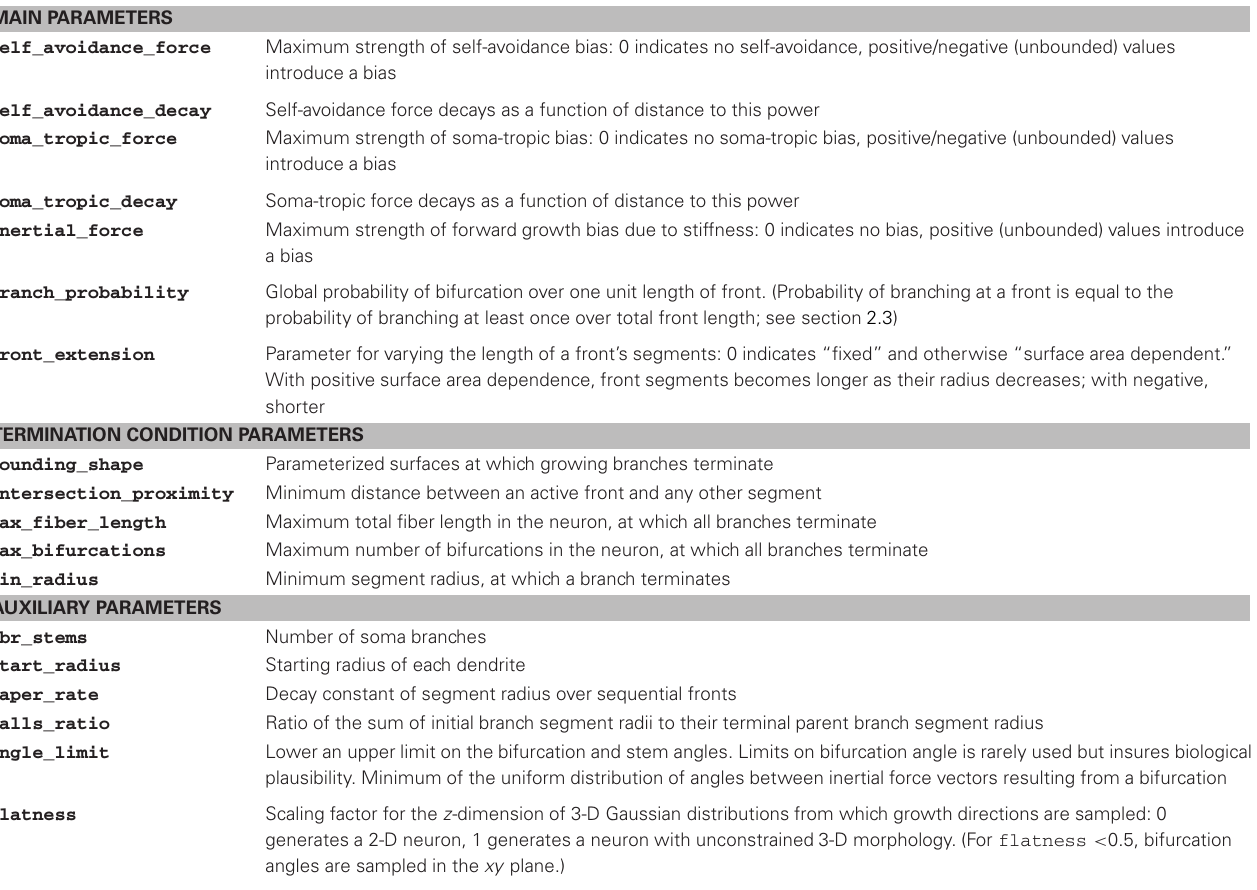
Table 1 | Parameters of the morphogenetic algorithm and their explanation. MAIN